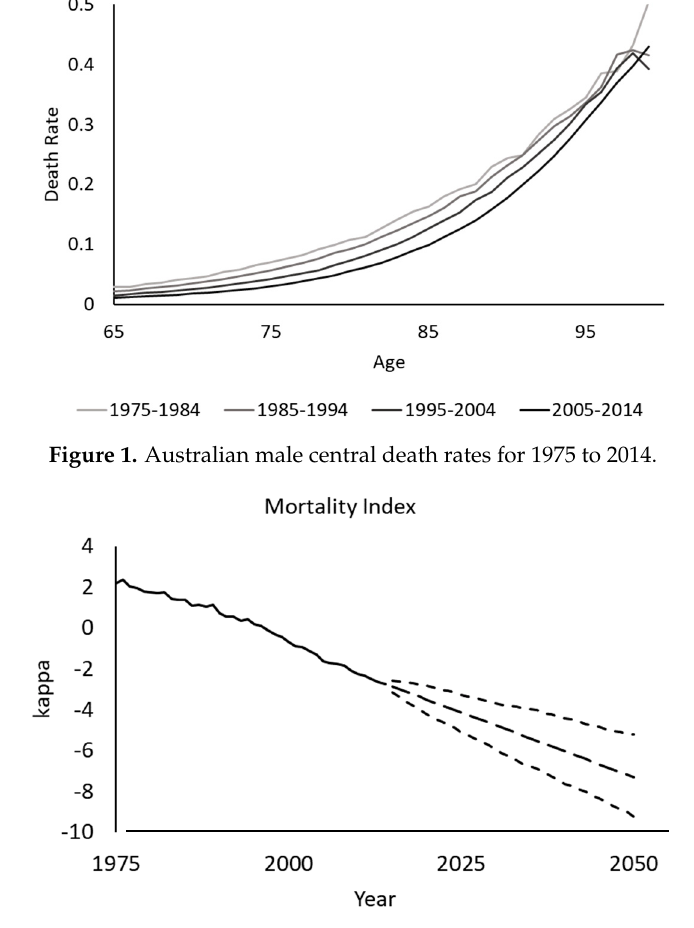
Figure 4. Australian quarterly residential property price index values (weighted average of Sydney, Melbourne, Brisbane, Adelaide, Perth, Hobart, Darwin and Canberra) and growth rates, and 3-month bank accepted bills yields, from September 2003 to June 2018.